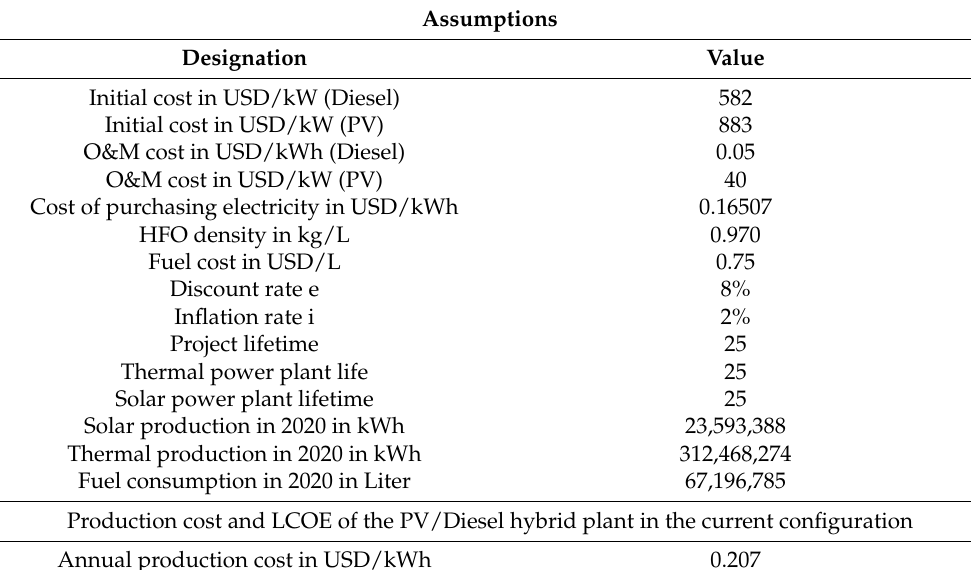
Table 11. Assumptions for the PV/Diesel hybrid plant [1,2,6,23,33,34] LCOE calculation